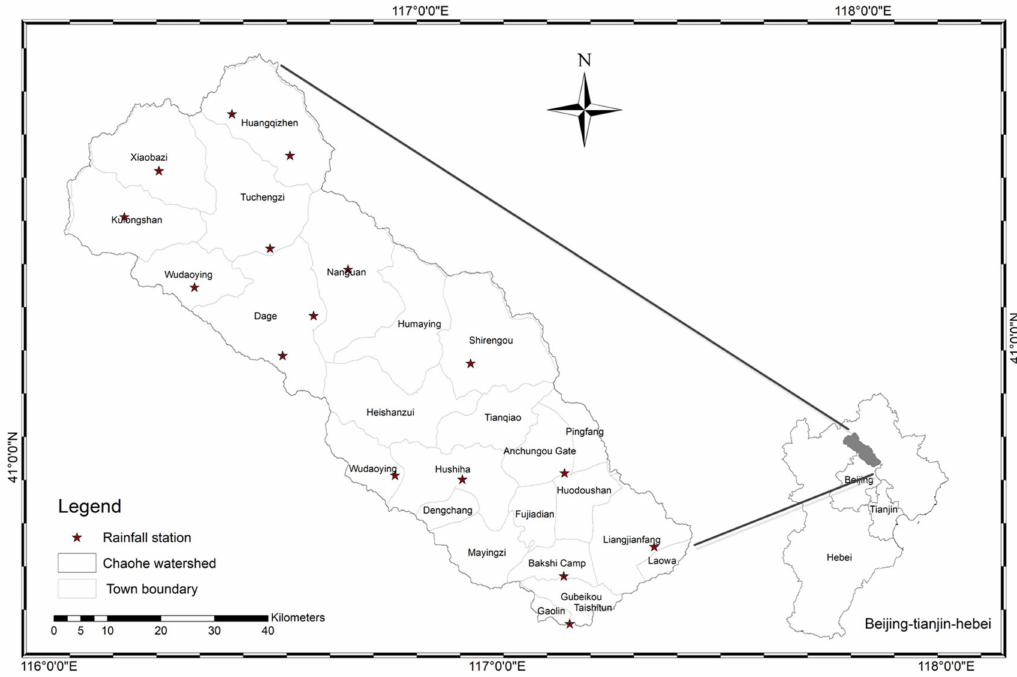
Figure 2. Map of the study